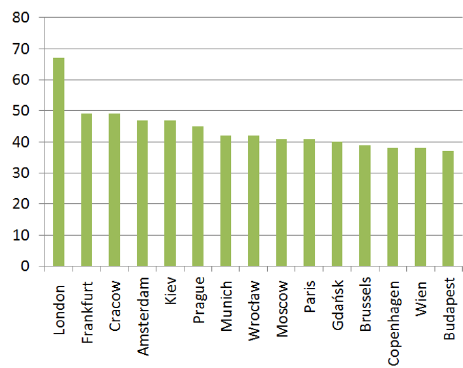
Fig. 7. The main destinations of flights from Warsaw Chopin Airport (25–31.03.2019)